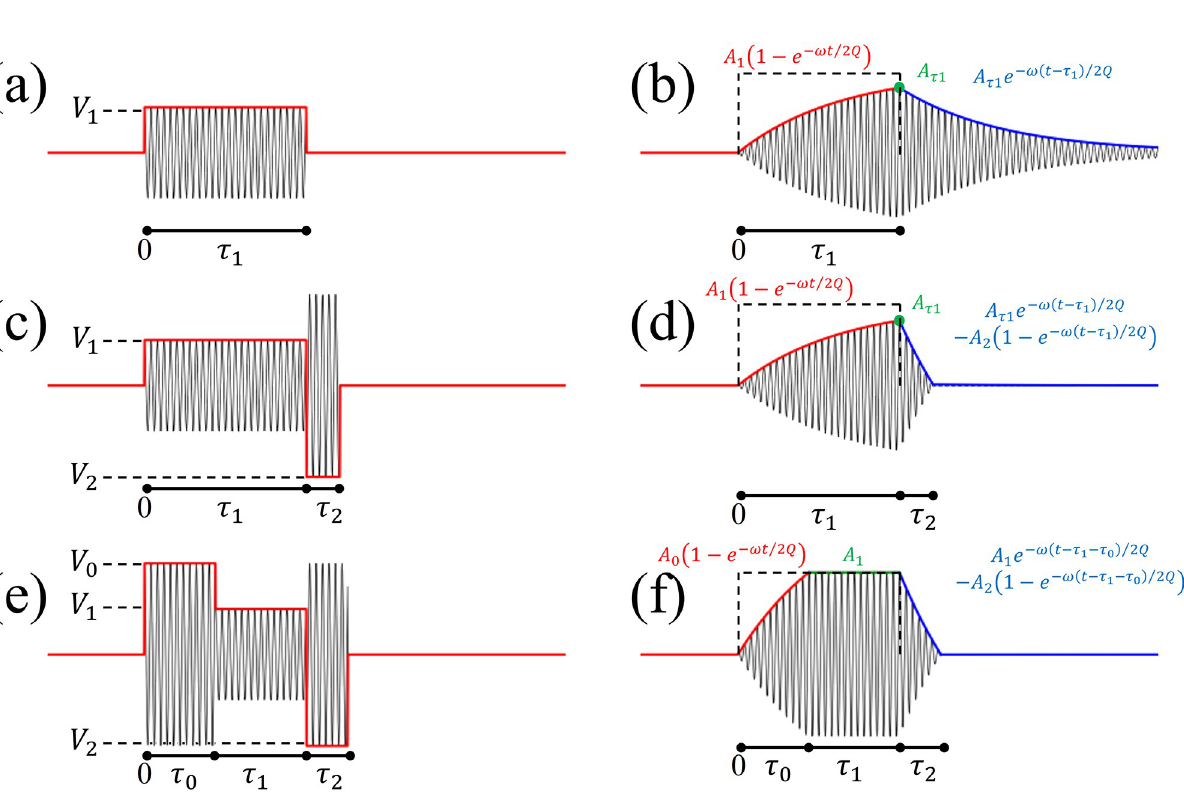
Fig 1. Three different RF pulses applied in the power amplifier (left column) and the actual signal generated by the RF coil (right column). (a) A square pulse and (b) its actual signal on the RF coil, (c) a square pulse with a post-pulse-damping lobe and (d) its actual signal on the RF coil, and (e) a square pulse with both pre-emphasis and a damping pulse and (f) its actual signal on the RF coil.